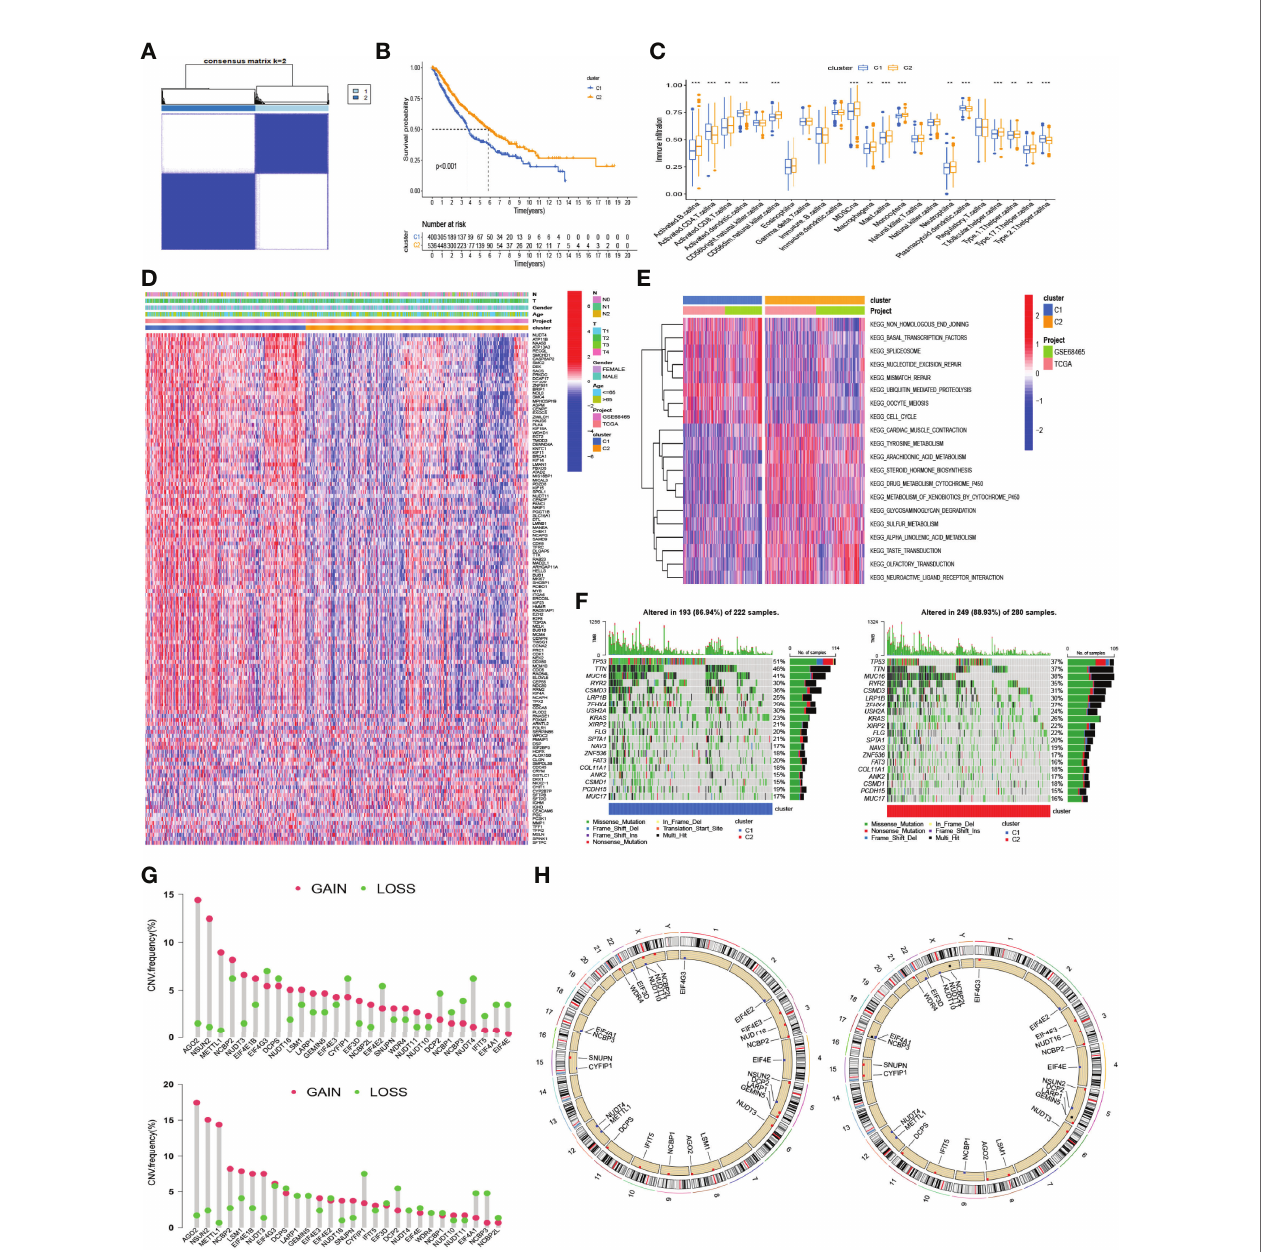
FIGURE 4 | Consensus clustering based on the expression of m 7 G-related genes. (A) The heatmap of the consensus matrix showing that 2 was the appropriate k value. (B) Kaplan – Meier curves for the OS in patients with different clusters. (C) The differences in the scores of immune cells between the two clusters. (D) Heatmap for the distribution of clinicopathologic characteristics and the difference of the expression of 130 DEGs between the two clusters. (E) Heatmap for the difference of biological process in GSVA enrichment analysis based on the KEGG gene set. (F) The waterfall plot showing the differences in somatic genomic mutation between cluster 1 (C1) and cluster 2 (C2). (G) Histogram re fl ecting the copy number variation (CNV) of the m 7 G-related genes in C1 (up) and C2 (down). (H) The location of CNV alteration of m 7 G-related genes on 23 chromosomes in C1 (left) and C2 (right). ** p < 0.01, *** p <